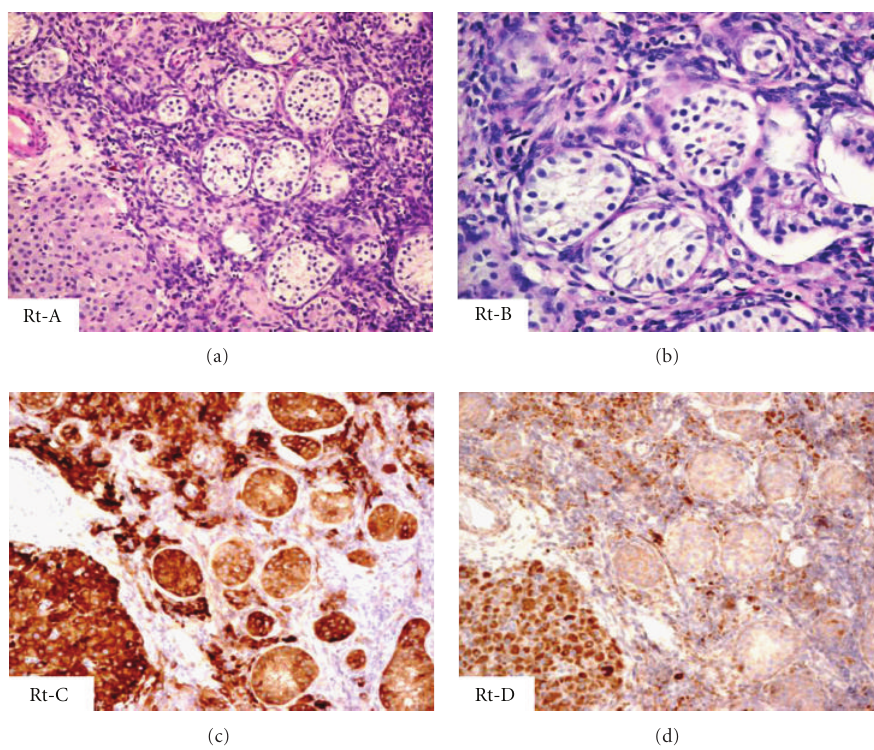
Figure 3: Histology of the right gonad (Rt). (a) Atrophic gonadal composed mainly of tubules of sertoli cells, with absence of germ cells, and the presence of interstitial Leydig cells, H&E × 100. (b) The Sertoli tubules show inactive epithelial cells, absence of germ cells or atypia, H&E × 200. (c) Both Sertoli cells and Leydig cells are immunoreactive to inhibin × 100, while only Leydig cells react to Neuron-Specific Enolase × 100